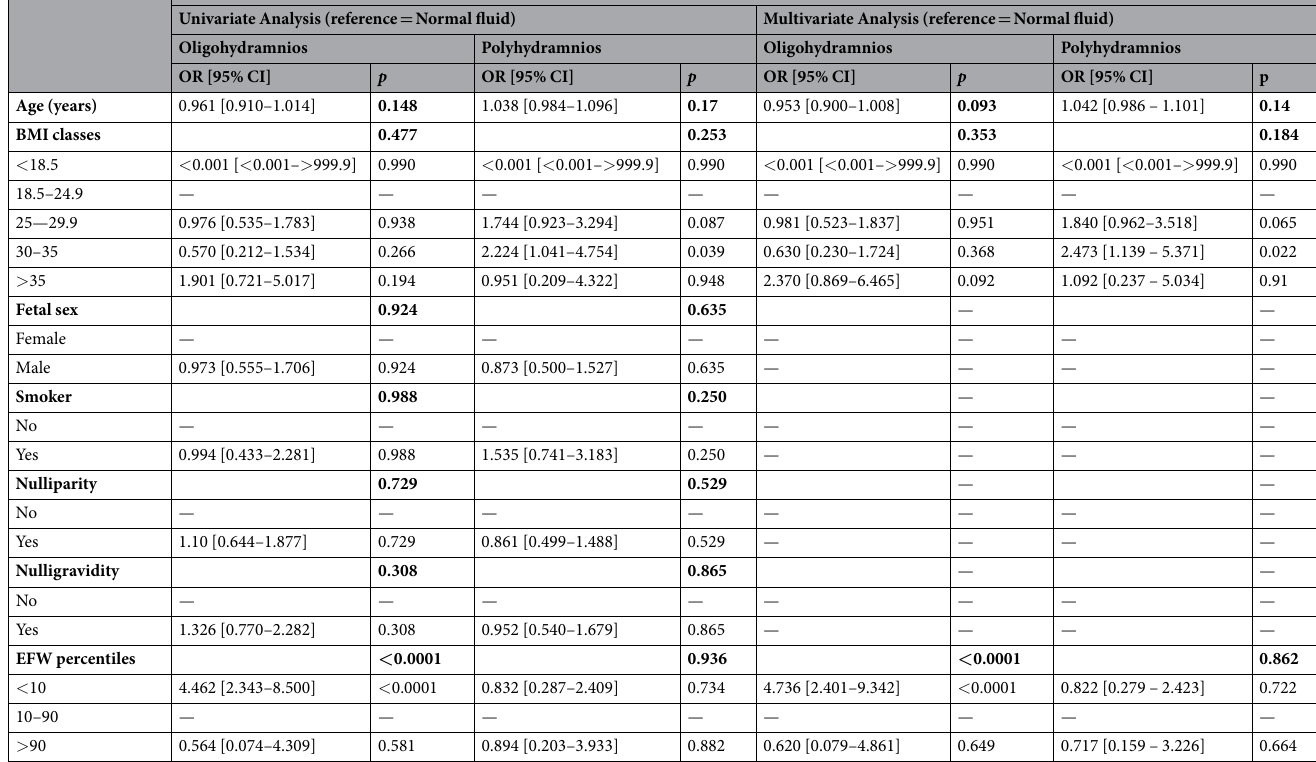
Table 2. Univariate and multivariate logistic regression analysis of the subjective methods (SM) in the second trimester